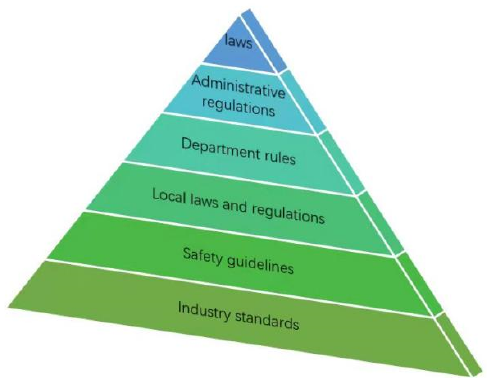
Figure 1. The Legal Framework on Commercial Nuclear Energy.